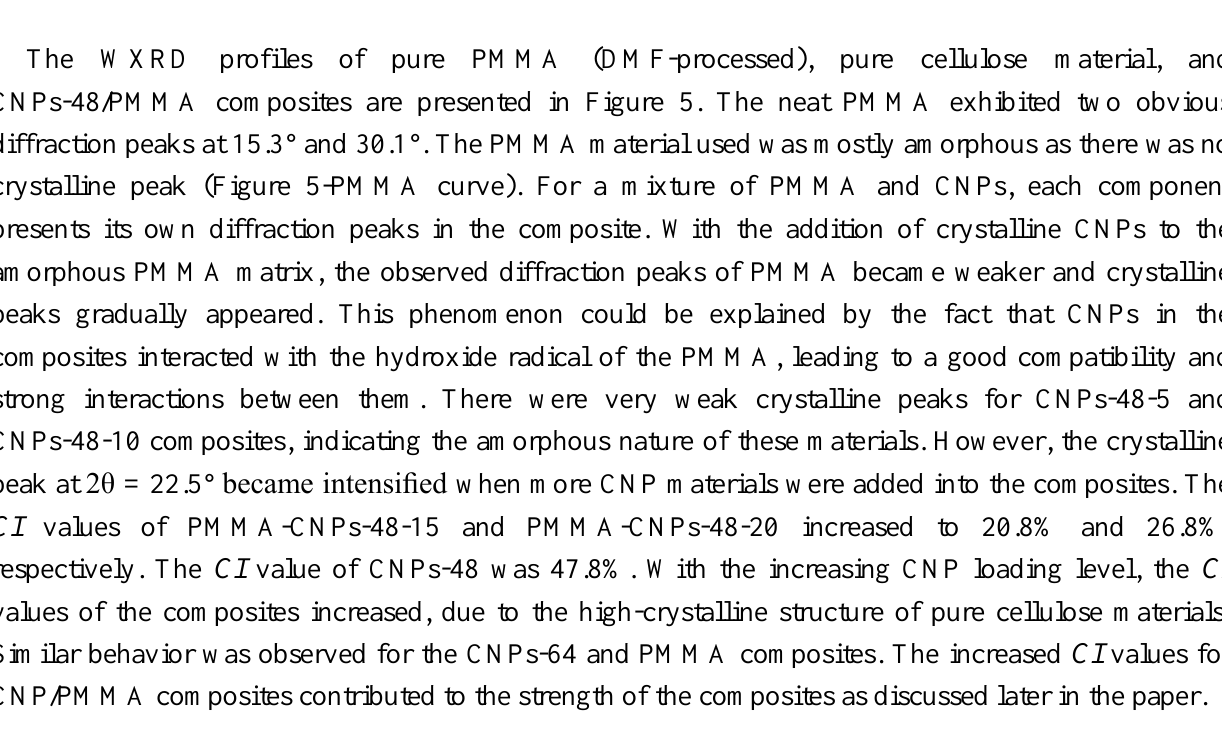
Figure 5. X-ray diffraction patterns of pure PMMA, pure cellulose materials and CNPs-48/PMMA composites at different CNP loading